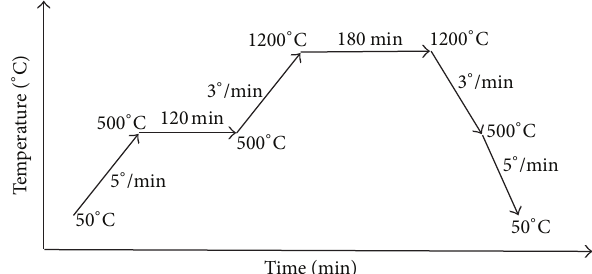
Figure 2: A schematic of sintering steps (the temperature and time scale factors are